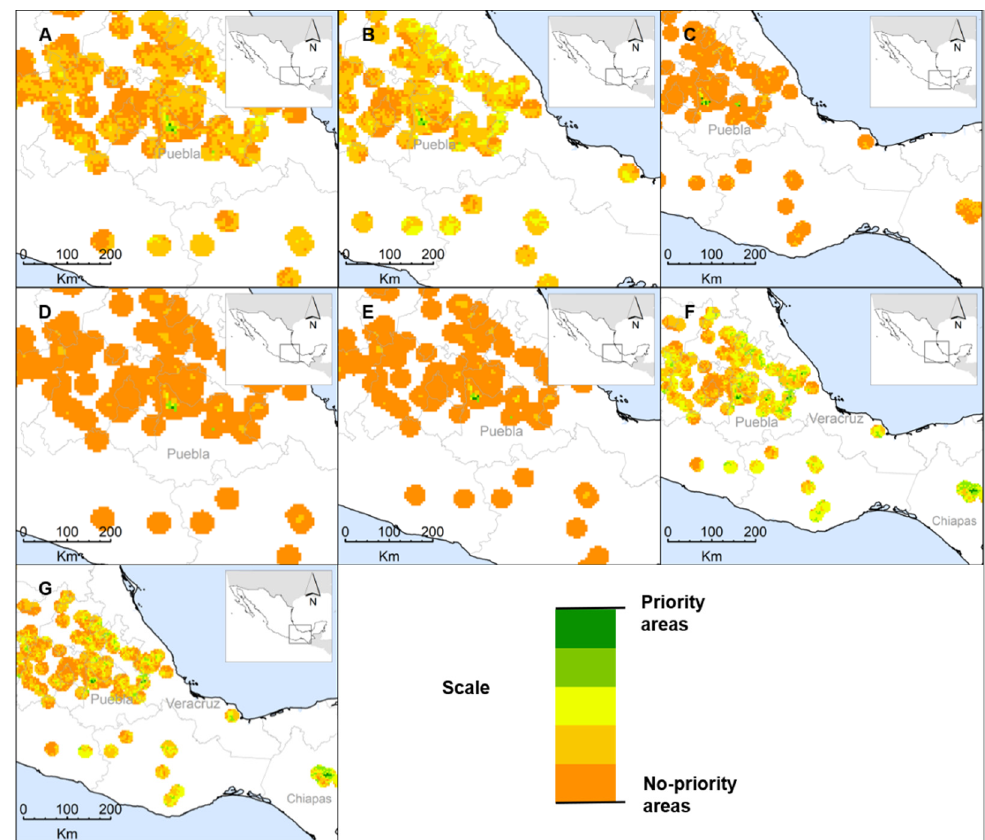
Figure 2. Priority area scenarios for the in situ conservation of cultivated hawthorn ( C. mexicana ), based on seven different criteria-map combinations. ( A ) S 1 —All criteria with the same weight. ( B ) S 2 —All criteria with weights assigned by experts. ( C ) S 3 —All criteria with weights assigned by AHP. ( D ) S 4 —HIC-EXP with the same weight. ( E ) S 5 —HIC-EXP with weights assigned by experts. ( F ) E 6 — HIC-AHP with the same weight. ( G ) S 7 —HIC-AHP with weights assigned by AHP. Table 3. Location and surface of priority areas for the conservation of wild hawthorn ( Crataegus spp.) and cultivated haw- thorn ( C. mexicana ) based on seven scenarios. S 1 —All criteria with the same weight. S 2 —All criteria with weights assigned by experts. S 3 —All criteria with weights assigned by AHP. S 4 —HIC-EXP with the same weight. S 5 —HIC-EXP with the weights assigned by experts. S 6 —HIC-AHP with the same weight. S 7 -HIC—AHP with weights assigned by AHP.